Question: Provide a one-line summary of what is displayed.
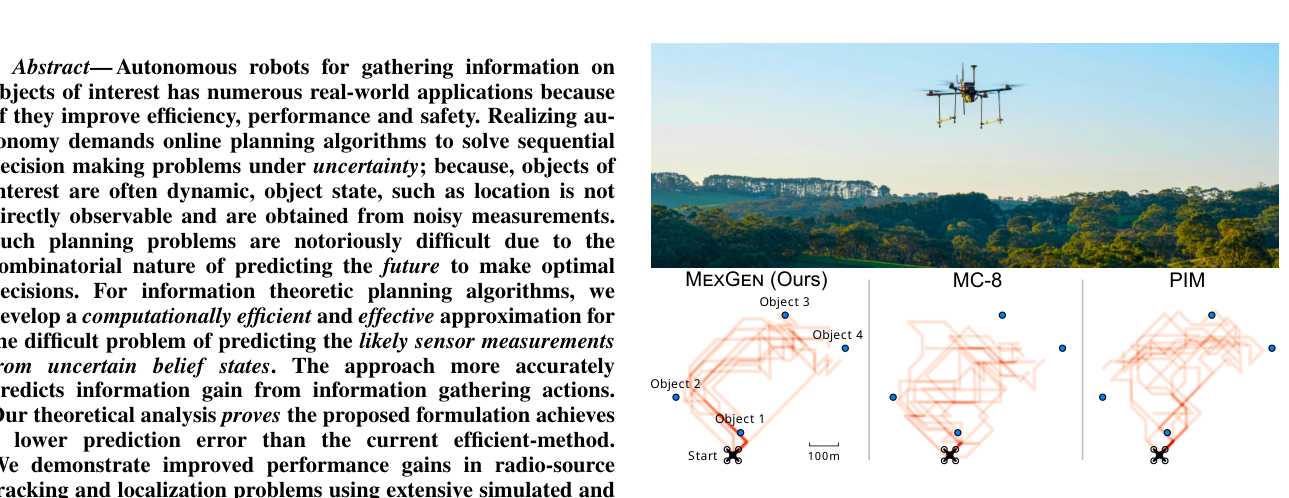
Answer: Trajectory heat maps from field experiments. We compared the current efficient method (PIM) and a computationally expensive method (MC-8) for computing information gain from possible future measurements with ours for a radio source localization task. Trajectory planning decisions, i.e. information gathering actions, are more effective with ours—resulting in a 40% reduction in mission completion times in the best case (vs. PIM, the next best method) and visibly shorter paths leading to consistently localizing the closest object and navigating to reduce the uncertainty of the next object (see § IV-D). The demonstration video is at: https://youtu.be/XrsCC6MkaB4